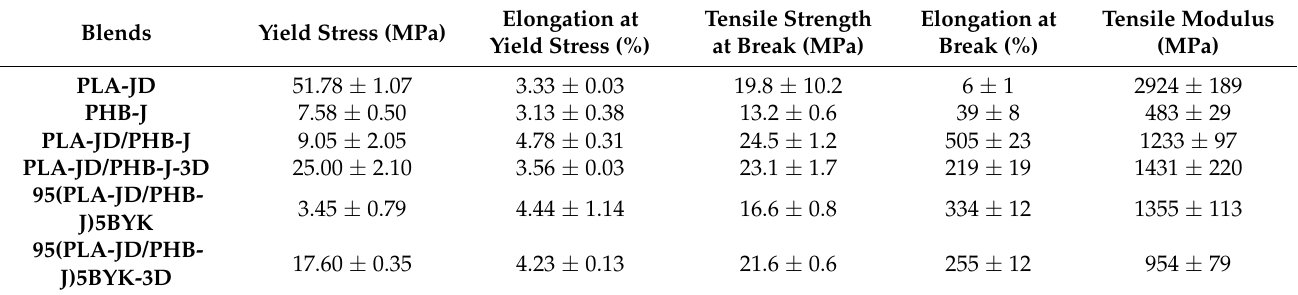
Figure 5. Tensile Stress–strain behavior of injected and printed blends. Table 3. Mechanical results of injected and 3D-printed PLA-JD/PHB-J and 95(PLA-JD/PHB-J)5BYK